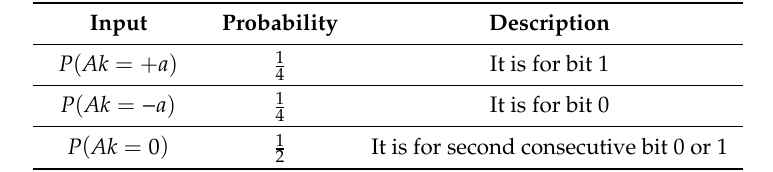
Table 2. Digital bit probabilities in SES.